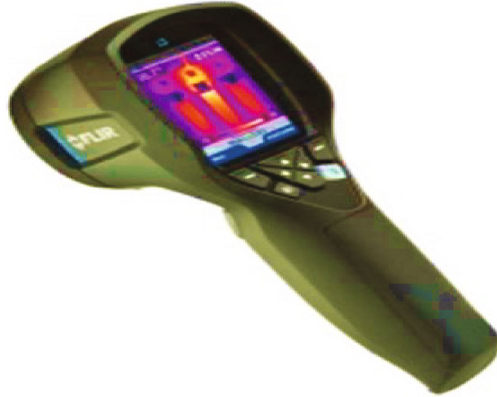
Figure 3: Thermal